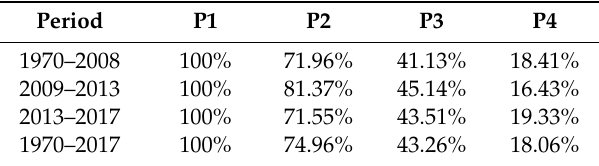
Table 19. Cumulative POS of all new drugs